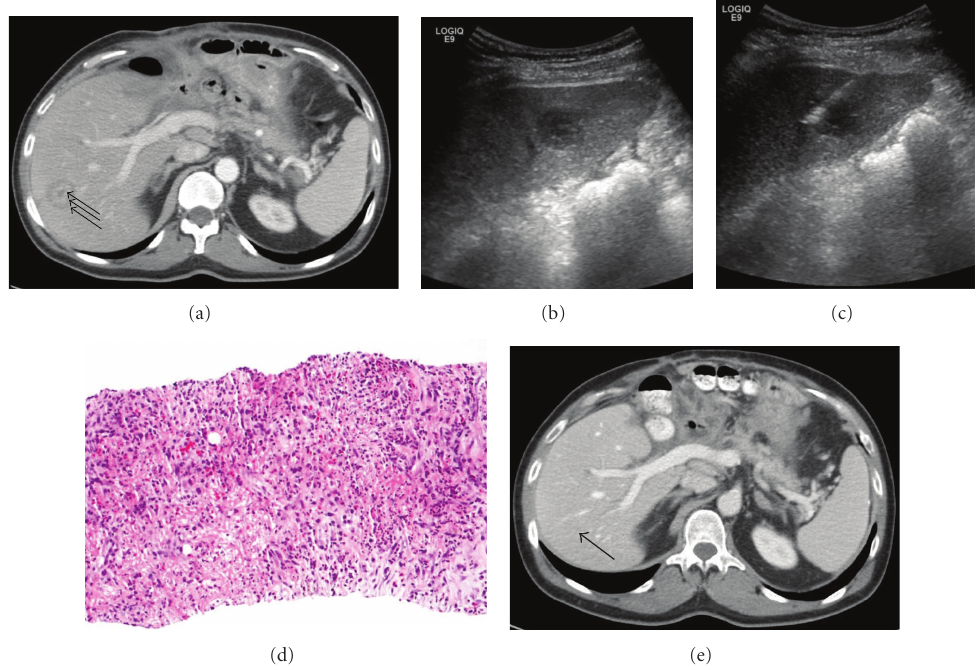
Figure 2: (a) Patient with history of pancreatic adenocarcinoma status after pancreaticoduodenectomy. Axial contrast-enhanced CT image obtained a few weeks after surgery showed three new liver lesions. This lesion in segment 8 has “double target sign” with three discrete layers (arrows). (b) Oblique image from ultrasound guided needle biopsy demonstrates another “double target sign” lesion in segment 6. (c) Biopsy needle within the segment 6 lesion. (d) Histologic examination of core specimens shows abundant neutrophils admixed with reactive fibroblasts. (e) Contrast-enhanced CT image three months after biopsy shows resolution of liver lesions. The area of the segment 8 lesion shown on (a) is marked by an